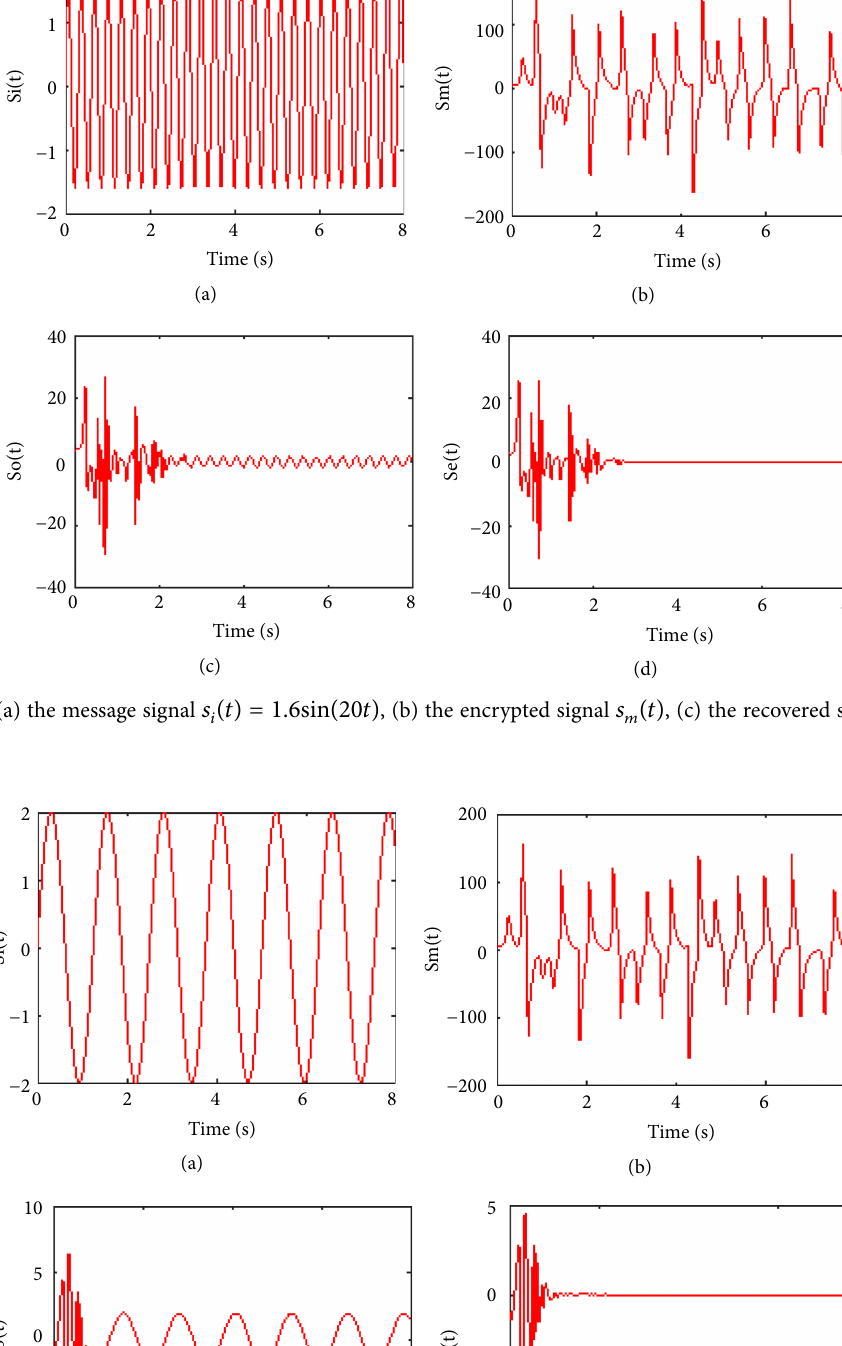
Figure 11: For switch-2 (a) The message signal 𝑠 error signal 𝑠